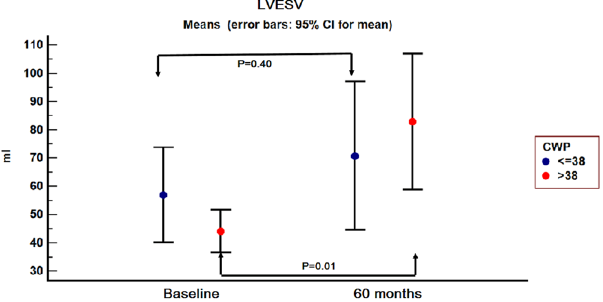
Figure 3. Left ventricular end-systolic volume evolution in the two groups from baseline to 60 months follow-up. 95% CI = 95% confidence interval; CWP = coronary wedge pressure; LVESV = left ventricular end- systolic volume.